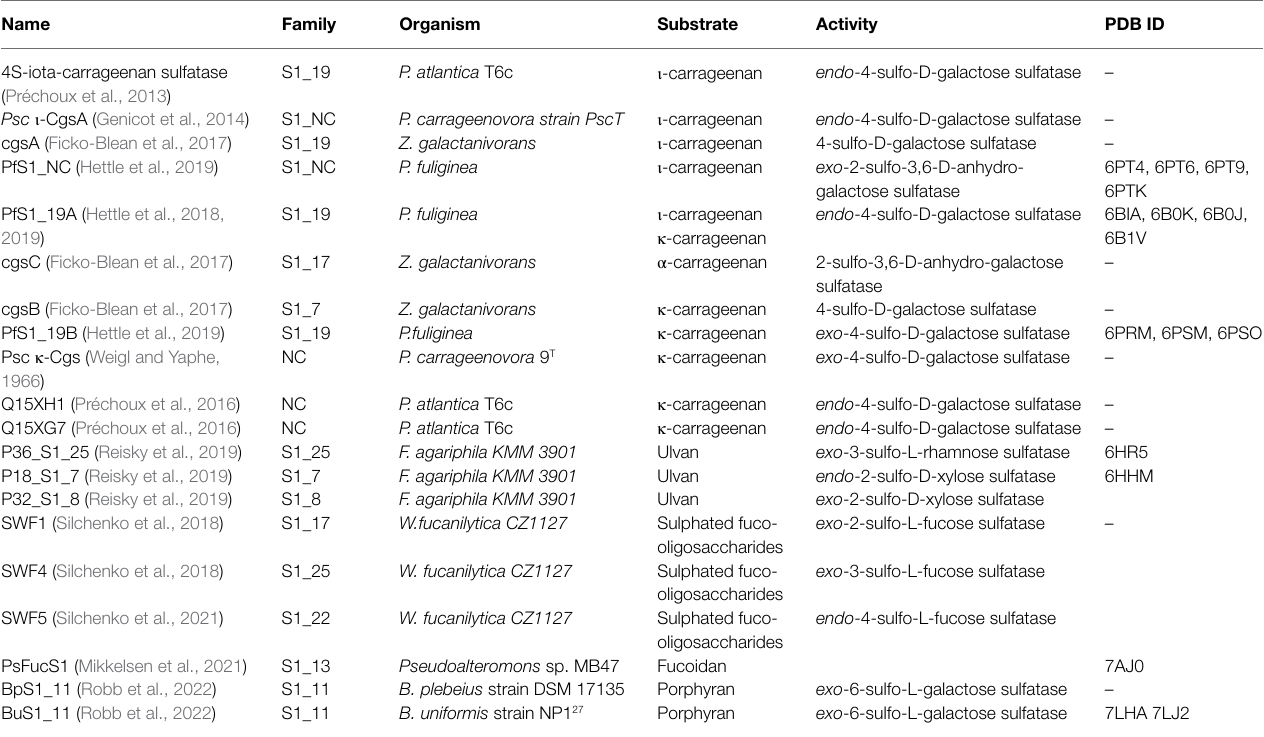
TABLE 1 | Table of reported algal polysaccharide-specific sulfatases from bacteria. Name